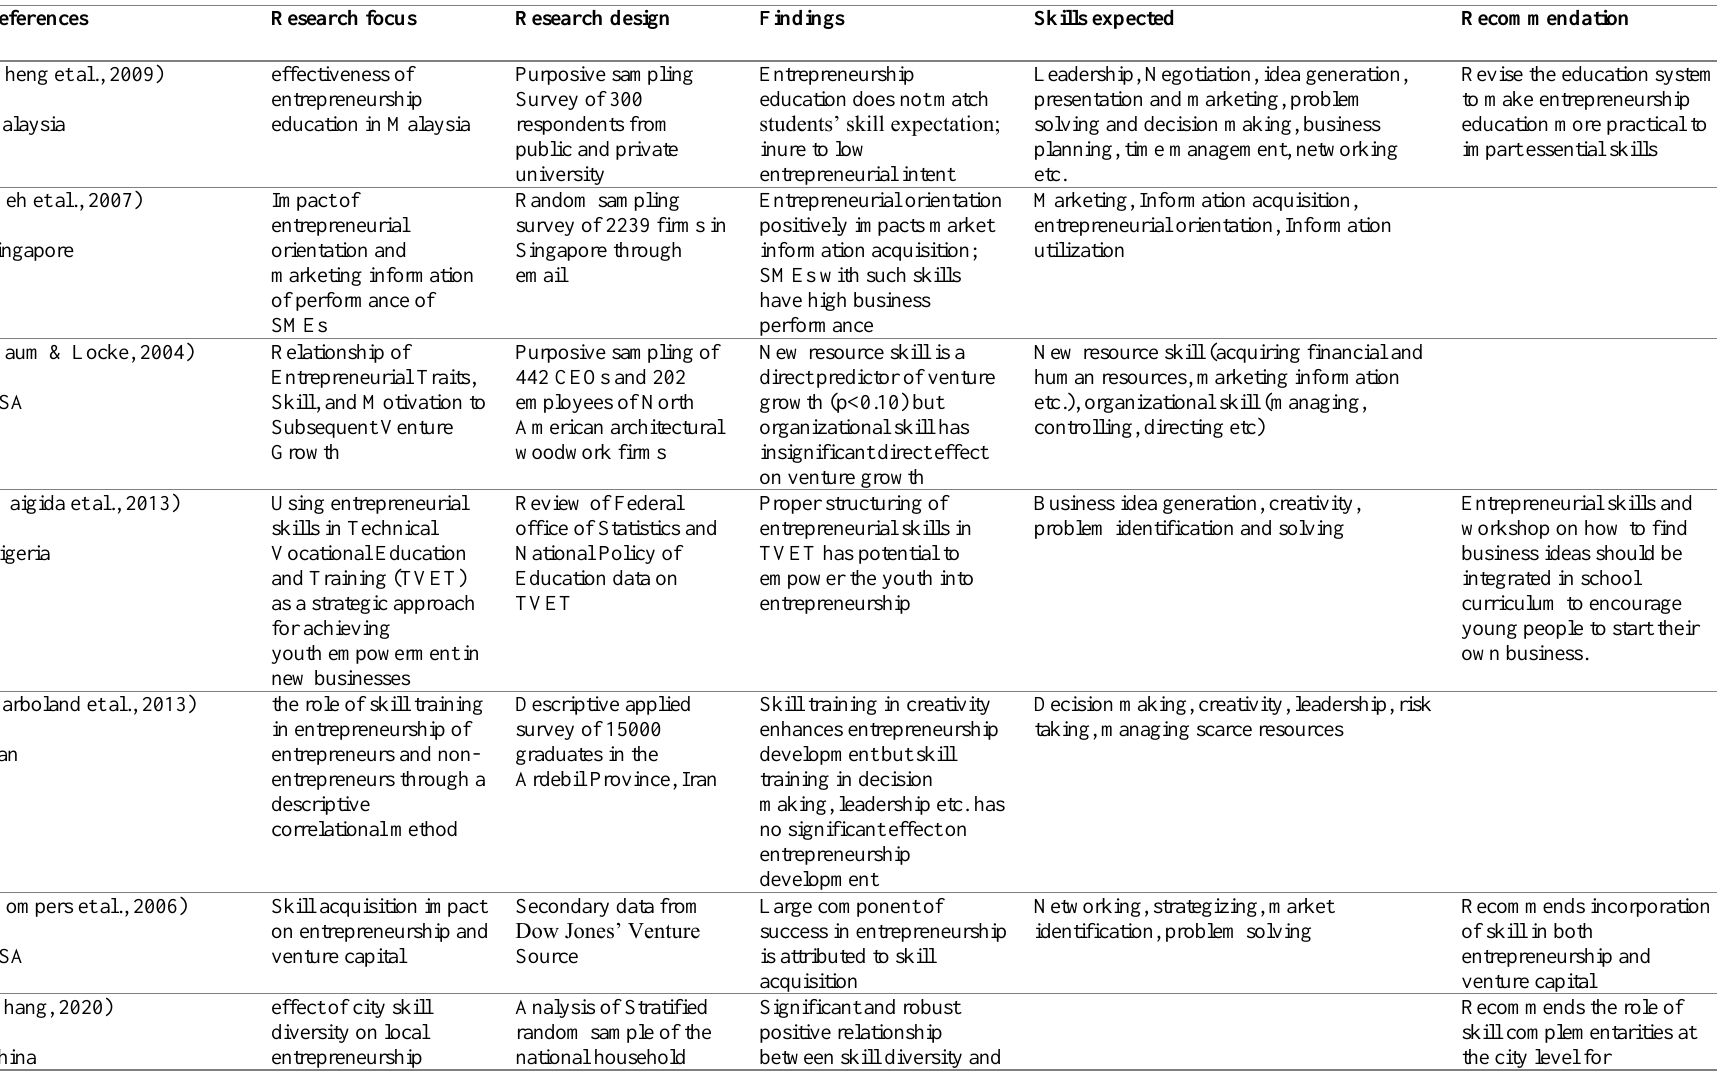
Table 1: Overview of Impact of Skill Acquisition on Entrepreneurship Development Across Twelve (12) Selected International Journal